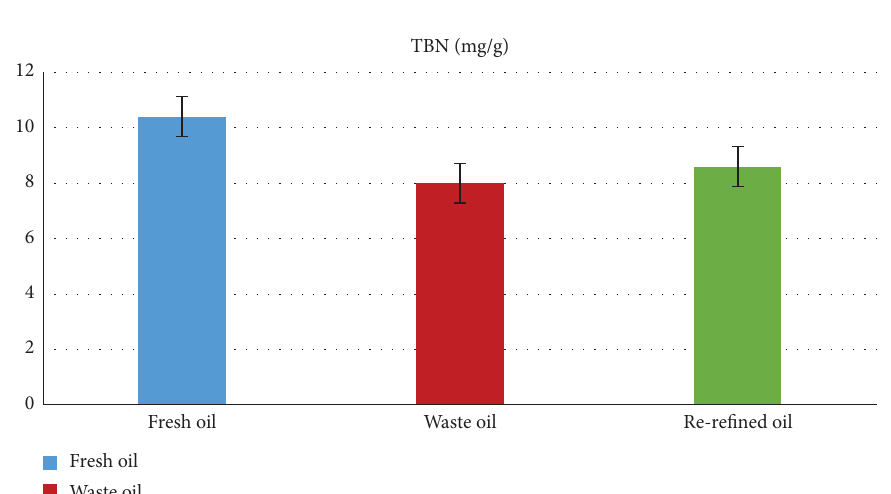
Figure 6: Flashpoint of the oil samples.